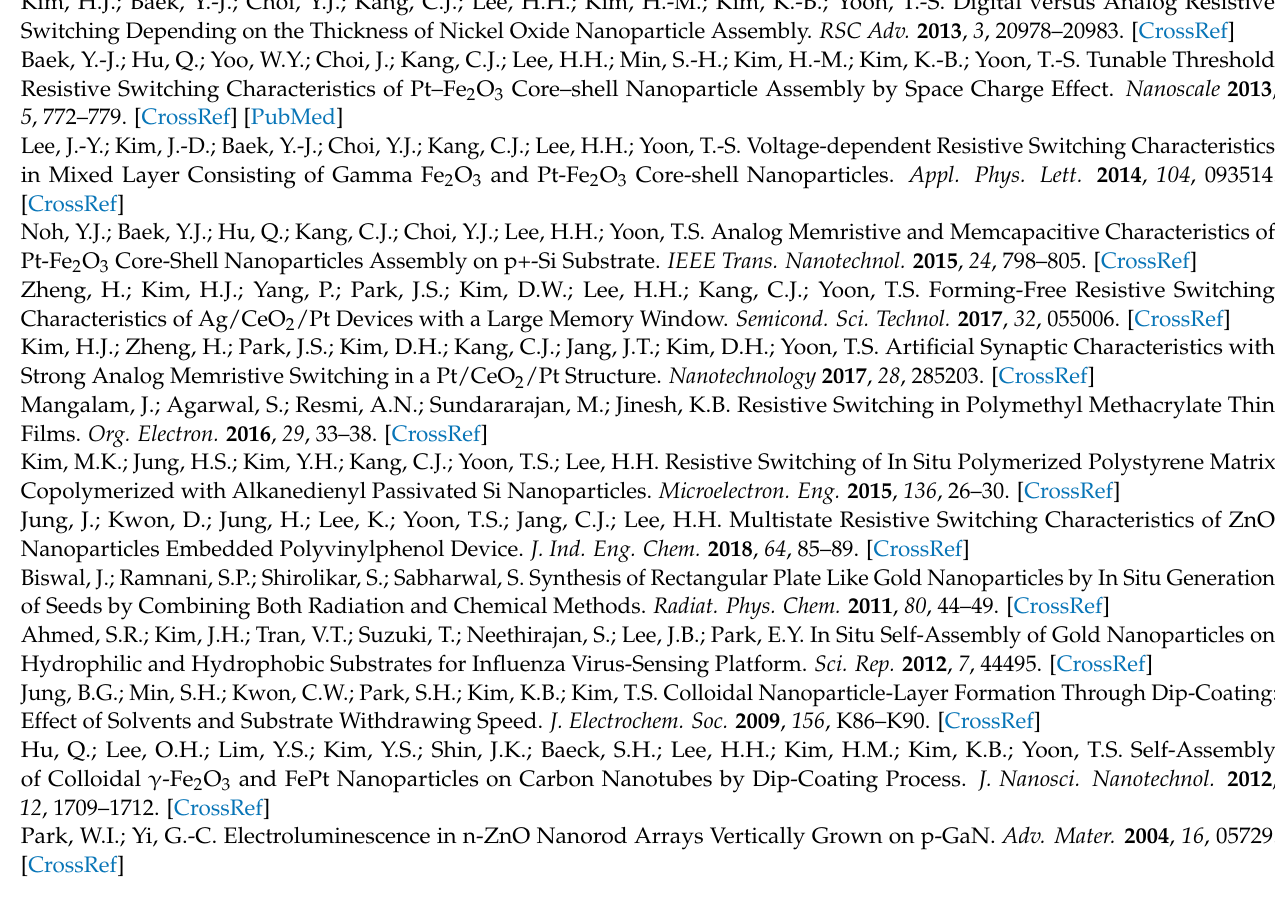
top electrode, and (b) EDS analysis of atomic ratio on surface of LaO x NPs layer, Figure S2: I–V characteristics of ten consecutive sweep of Al/ LaO x NPs/Pt device, Figure S3: Replot of I–V in figure (b) with the form of SCLC at (a) +3 V, +5 V sweep, (b) − 3 V, − 5 V sweep, (c) +7 V, +9 V